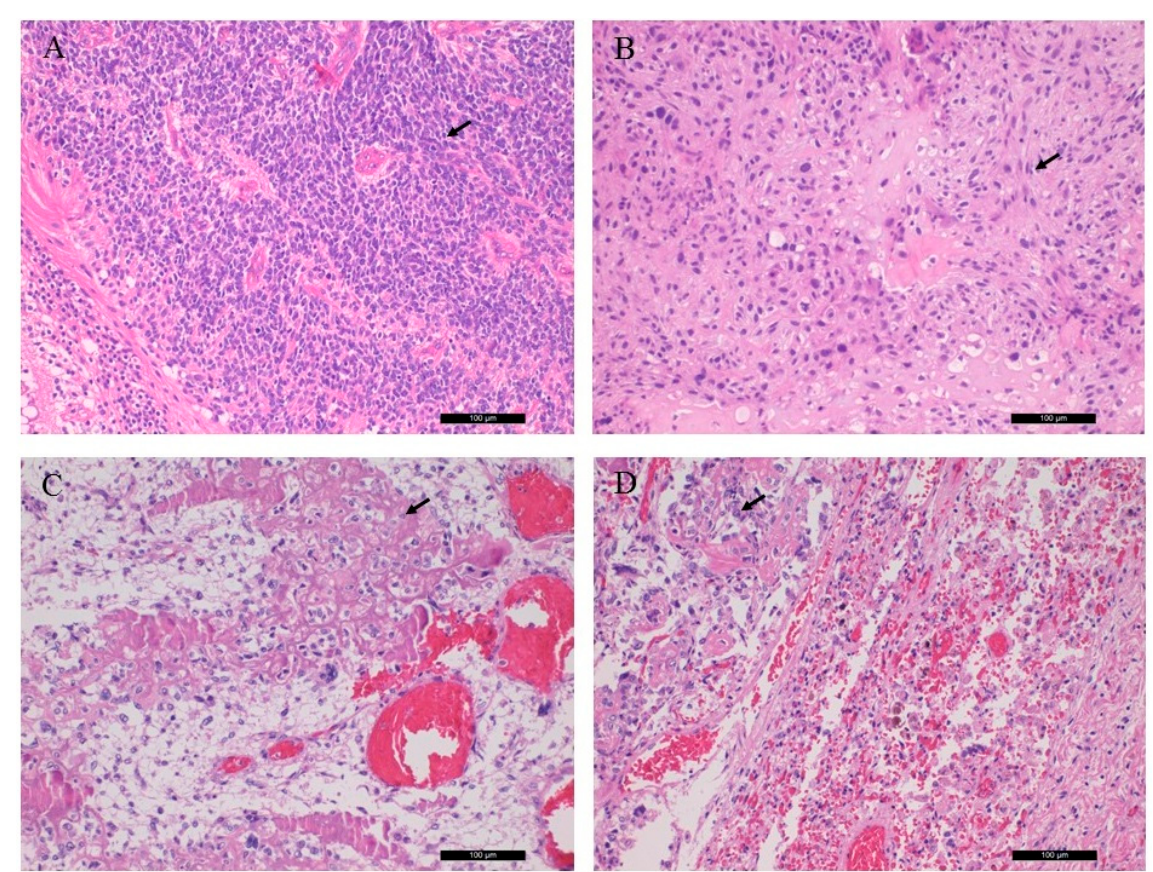
Figure 1. Conventional histological (H&E) characteristics of patient tumor samples. ( A ) Rb of the right eye bulb, ( B ) chondroblastic osteosarcoma of the left orbital bone, ( C ) osteoblastic osteosarcoma from the left tibia, ( D ) osteoblastic osteosarcoma, pulmonary metastasis. Arrows indicate retinoblasts, as well as chondroblastic and osteoblastic propagation (magnification: ×20).